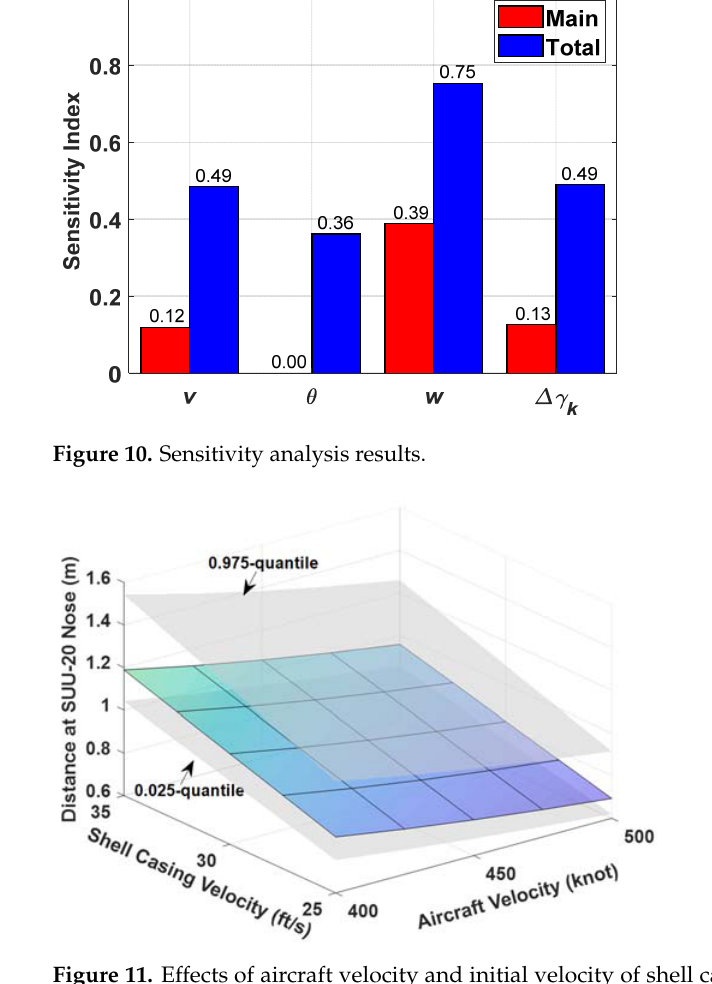
Figure 11. Effects of aircraft velocity and initial velocity of shell cases on distance of shell cases at nose of an SUU ‐ 20.